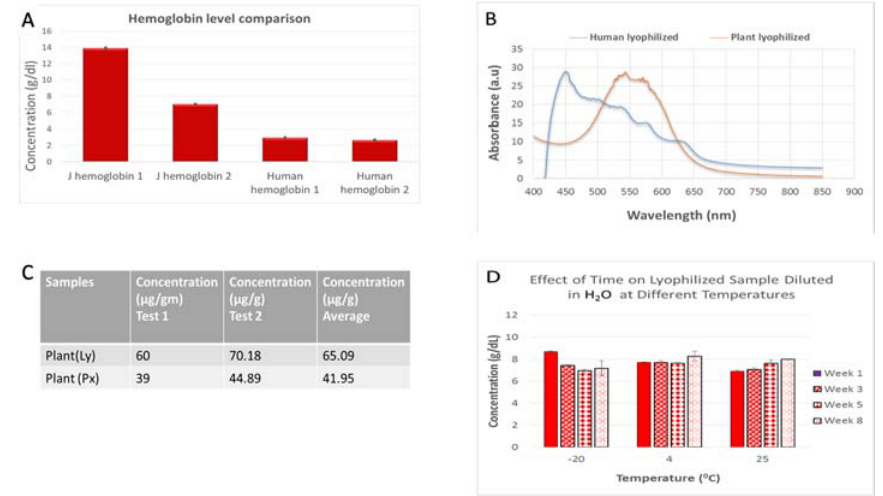
Figure 2. ( A ) Concentration of hemoglobin in isolated lyophilized powder from Justicia leaves reconstituted in water at different concentrations (J hemoglobin 1 and J hemoglobin 2) compared to concentration of hemoglobin in a similar mass of human hemoglobin lyophilized powder from MP Biomedicals (Human hemoglobin 1) and Sigma–Aldrich (Human hemoglobin 2). ( B ) Ultraviolet ‐ visible (UV ‐ VIS) spectroscopy of isolated Justicia plant powder compared to human hemoglobin lyophilized powder. ( C ) ELISA results further confirming hemoglobin activity in isolated lyophilized J usticia leaf extract dissolved in water at high concentration (Ly) and low concentration (Px); ( D ) Change in hemoglobin concentration levels as a function of different storage temperature over time.